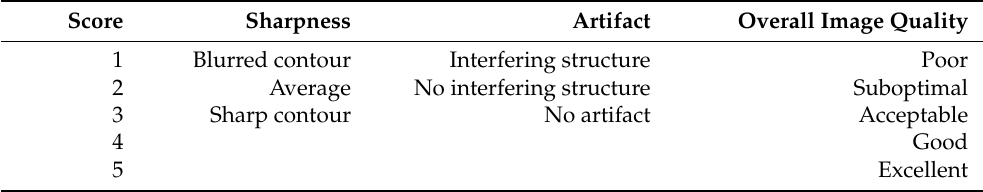
Table 1. Qualitative scales of image sharpness, noise, and overall image quality. Score Sharpness Artifact Overall Image Quality